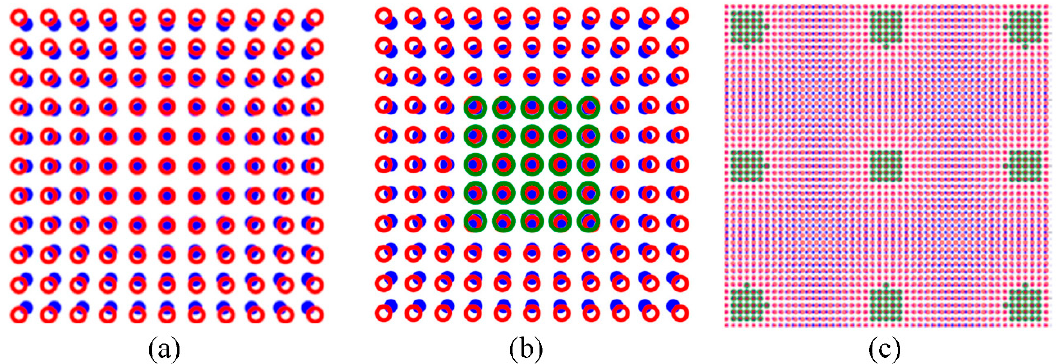
Figure 2. Artificial 2D lattices for illustrating the secondary step in the near-row-matching method. Each point in ( a ) represents a row of points projected along the good-matching direction, showing good matching between adjacent rows. The plane in ( b ) contains horizontal rows of good matching within and between the rows. A GMS cluster is identified with green circles around the GMSs. Periodic distribution of GMS clusters in the plane is seen in ( c ).